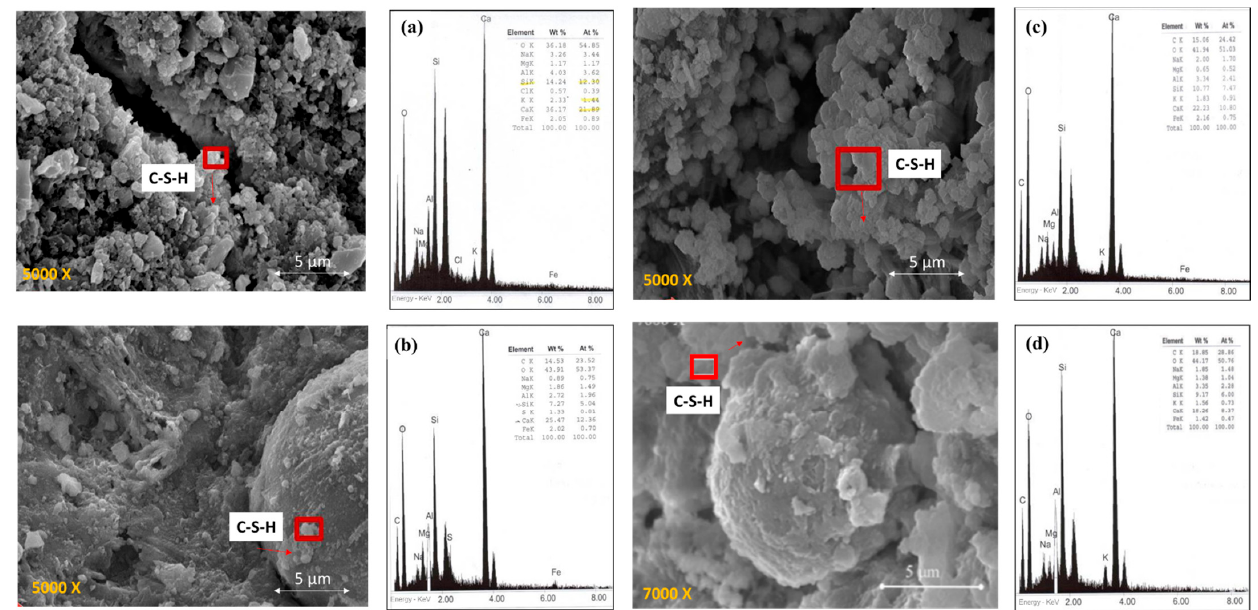
Figure 3. SEM surface morphology micrographs and elemental analysis by X-ray dispersive energy spectroscopy (EDS) of specimens made with the OPCFA mixture: ( a ) 2OPCFA-P Ca/Si = 1.78, ( b ) 2OPCFA-OP Ca/Si = 2.45, ( c ) 3OPCFA-P Ca/Si = 1.44, ( d ) 3OPCFA-OP Ca/Si = 1.40.